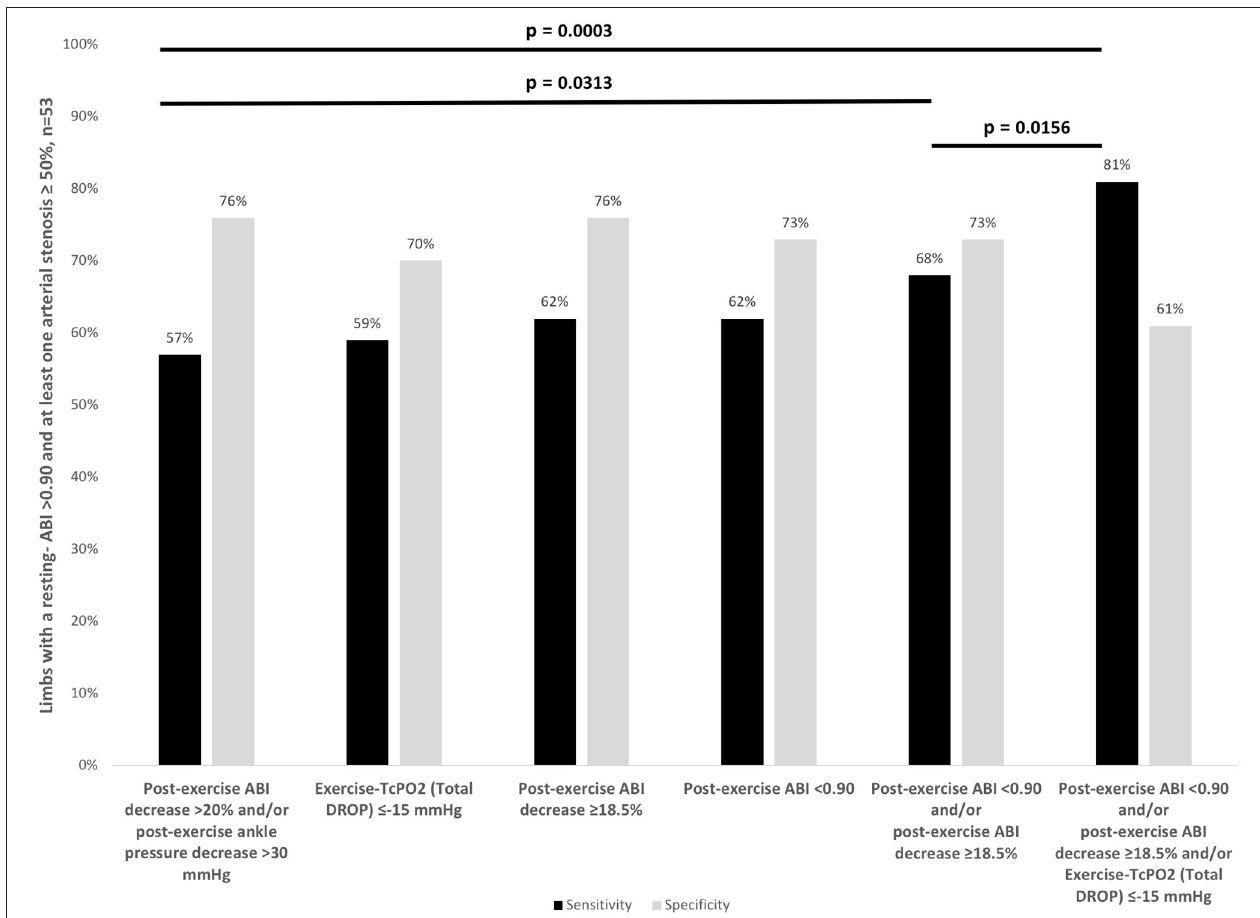
FIGURE 2 | Sensitivity and specificity of exercise tests criteria to diagnose Lower Extremity Peripheral Artery Disease (LEPAD) in patients with an ABI > 0.90 and at least one arterial stenosis ≥ 50%. CI, confidence interval; ABI, Ankle-Brachial Index; DROP, Delta from Resting Oxygen Pressure.